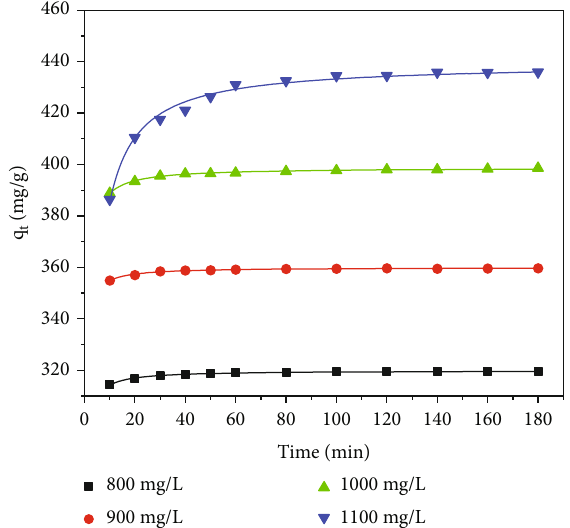
Figure 3: Adsorption kinetics model of CaFe MB with di ff erent initial